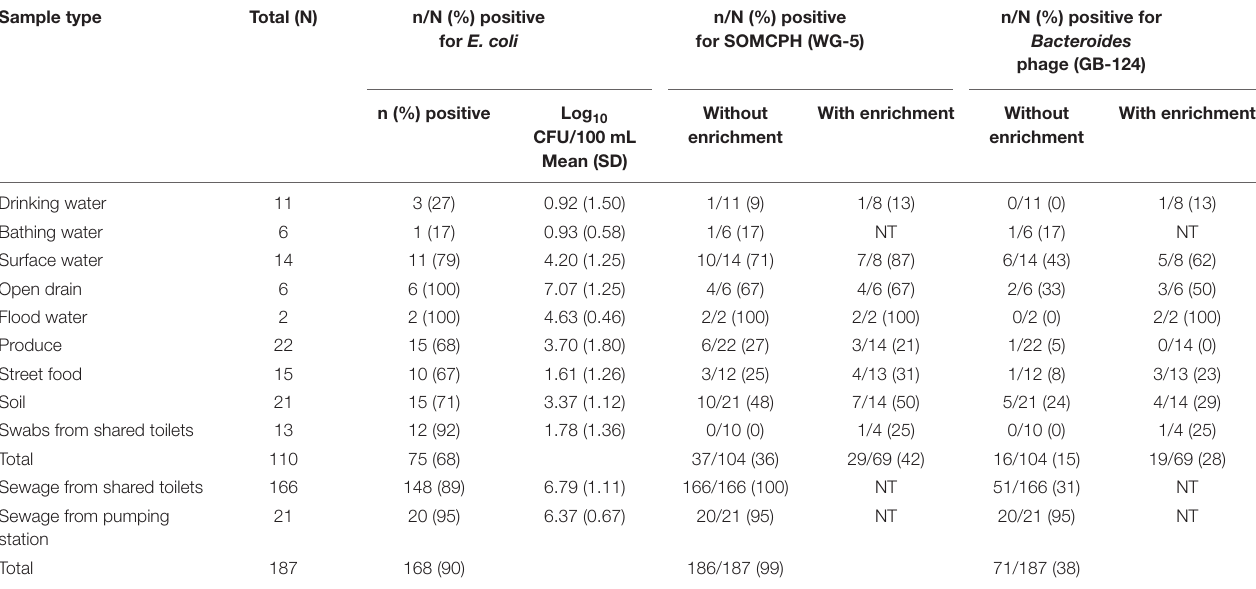
TABLE 2 | Fecal indicator bacteria ( E. coli ) and phages (SOMCPH and GB-124) detection (with and without enrichment) in environmental samples from two study neighborhoods and selected municipal pumping station samples in Kolkata ( n = 297). Sample